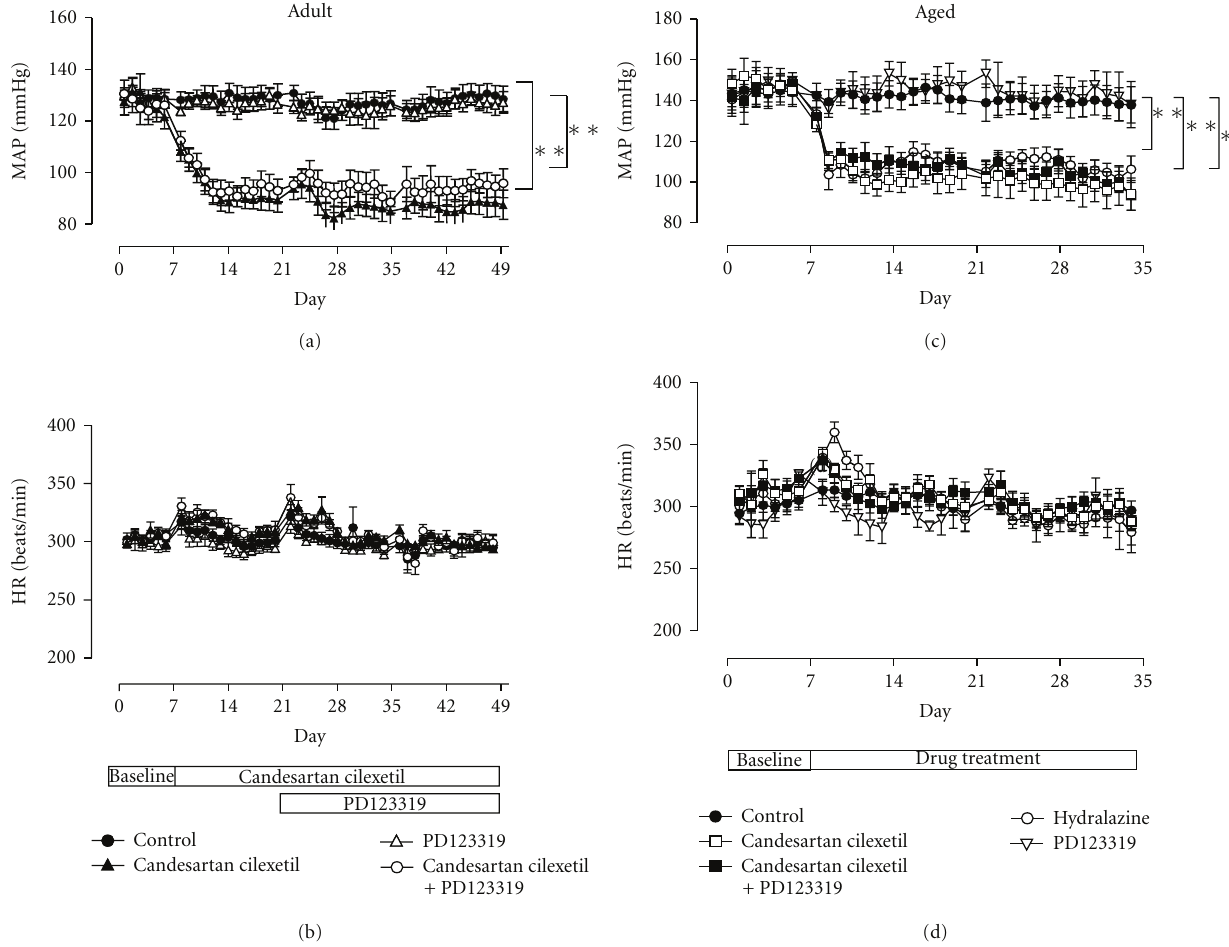
Figure 1: Radiotelemetry recordings of (a) MAP and (b) HR of adult SHRs, at baseline and during treatment with vehicle (control, n = 6), candesartan cilexetil (2mg/kg/day) alone ( n = 7) or in combination with PD123319 (10mg/kg/day, n = 7), or PD123319 alone. Analogous radiotelemetry recordings of (c) MAP and (d) HR of senescent SHRs, at baseline and during treatment with vehicle (control, n = 10), candesartan cilexetil alone ( n = 9) or in combination with PD123319 ( n = 9), PD123319 alone ( n = 4), or hydralazine (30mg/kg/day, n = 7). ∗∗ P < 0 . 01 versus control (2-way